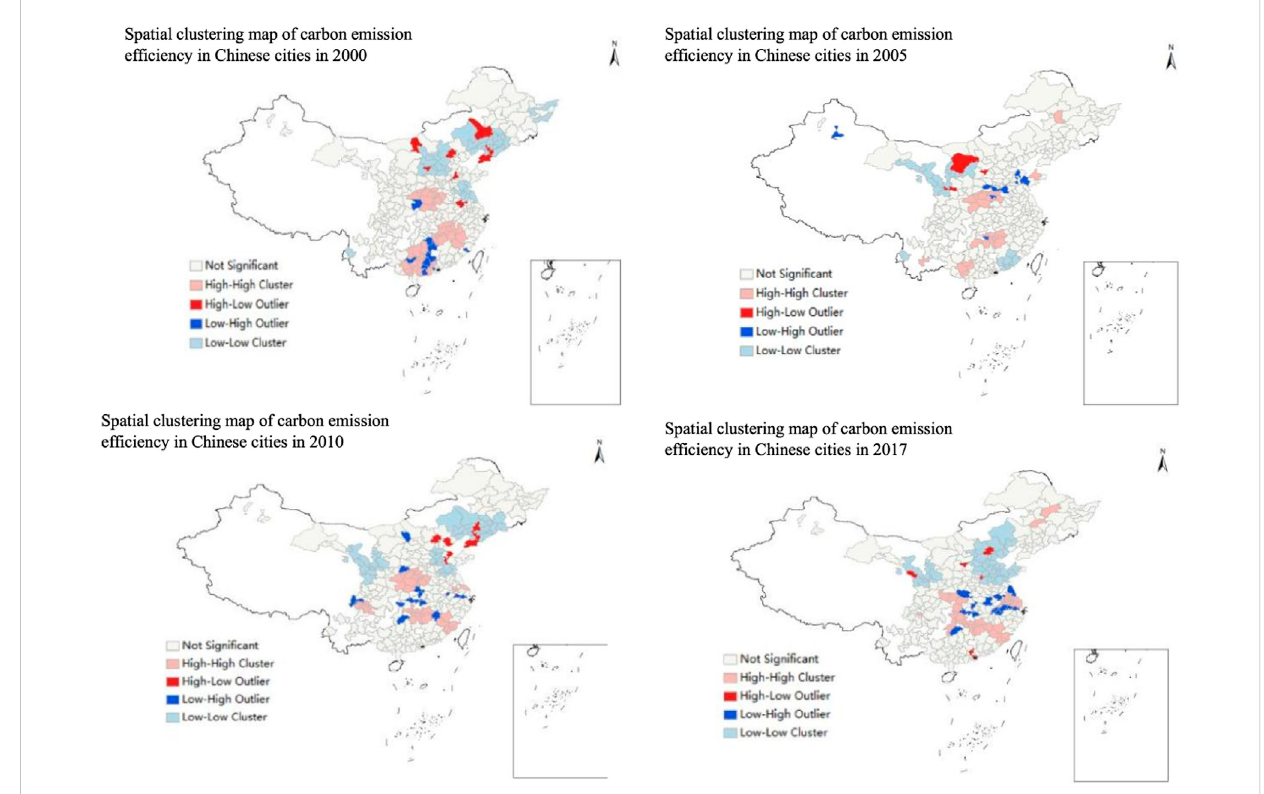
FIGURE 4 Spatial clustering map of carbon emission ef fi ciency in Chinese cities.